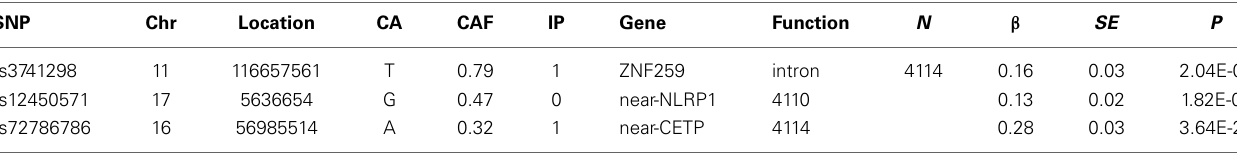
Table 2 | GWA results for the most significant SNP ( p < 5 . 0E-08) at each locus for plasma levels of HDL.